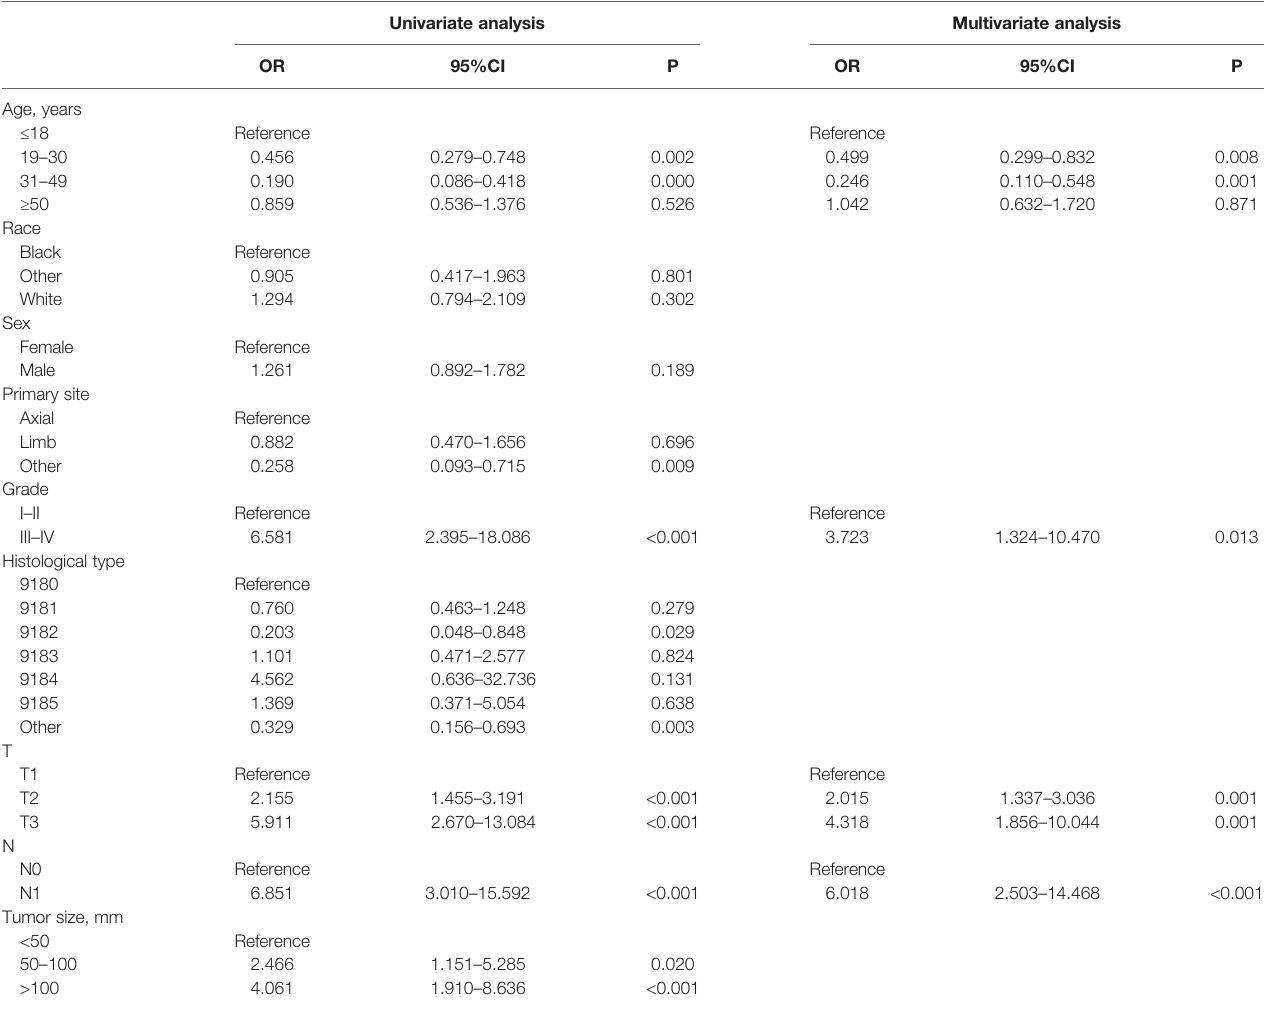
TABLE 2 | Univariate and multivariate logistic analyses of distant metastasis in osteosarcoma patients. Univariate analysis Multivariate